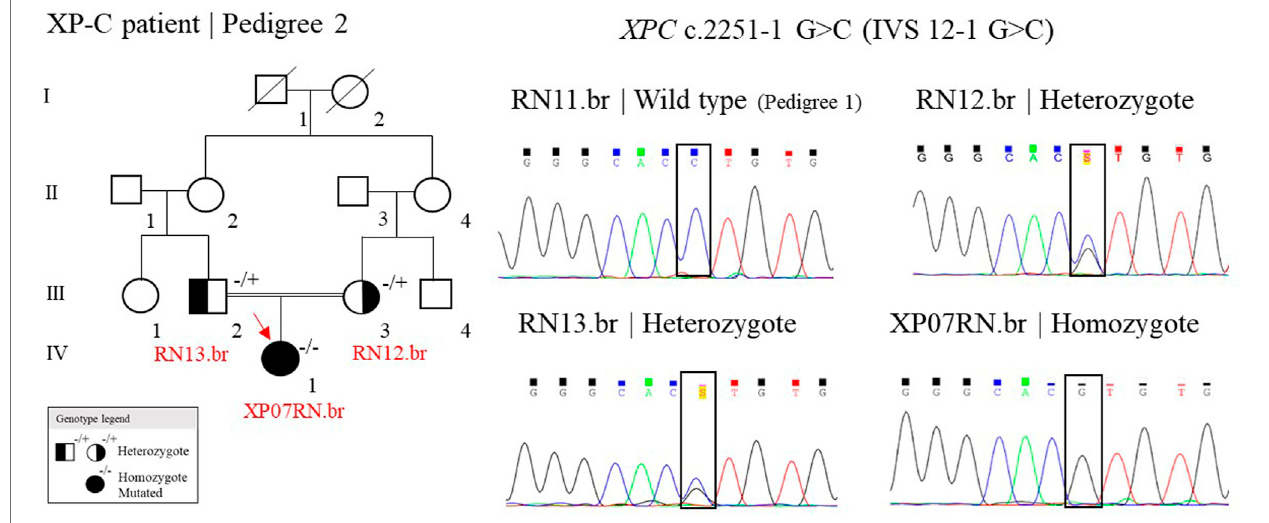
FIGURE 4 | Genealogy and genotype from the XP-C family at Pedigree 2 and the electropherogram picture of the Sanger reaction at the XPC mutation site. Samples genotyped by Sanger have their ID. The red arrow indicates the patient sequenced by NGS. (+/+) represent wild type, ( − /+) heterozygote, and ( − / − ) homozygote